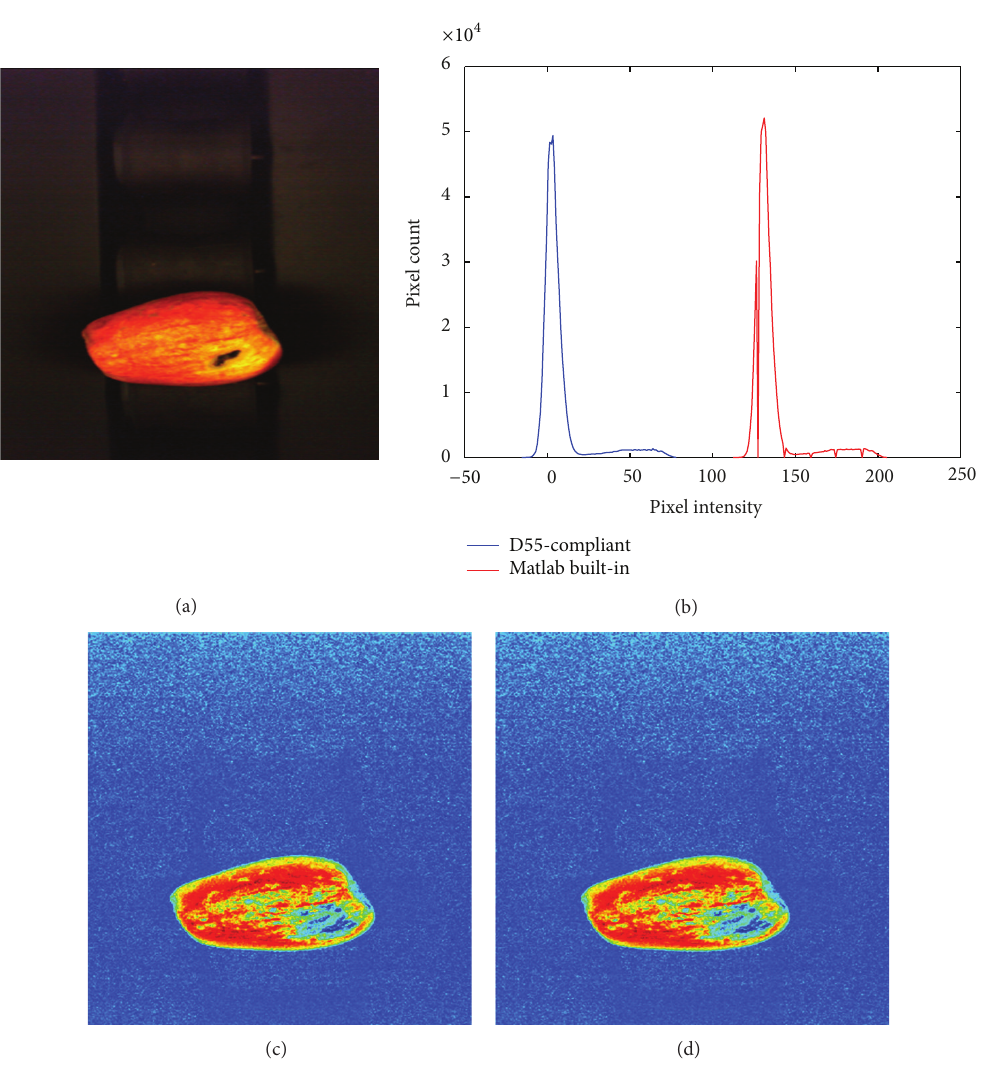
Figure 10: CIE 𝐿 ∗ 𝑎 ∗ 𝑏 ∗ / 𝑎 component transform results; (a) original image; (b) histogram comparison (c); transform results according to D55-compliant program; (d) transform results according to matlab built-in rgb2lab